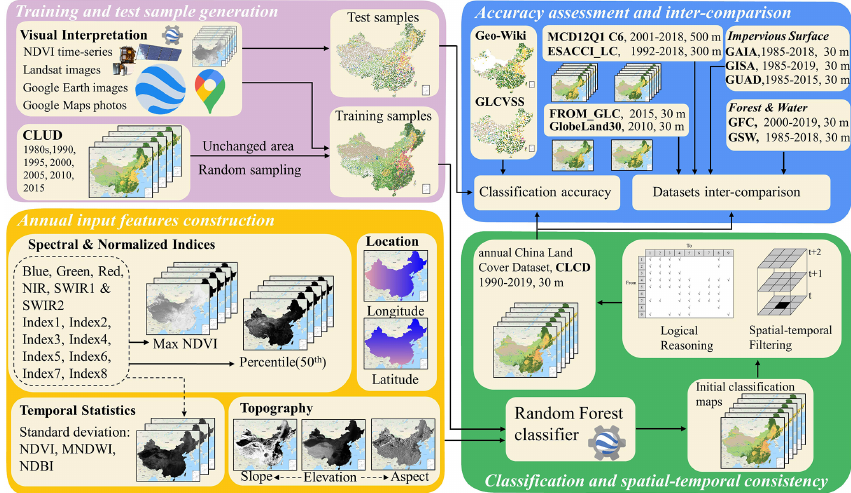
Figure 1. The flow chart to generate the CLCD (annual China land cover